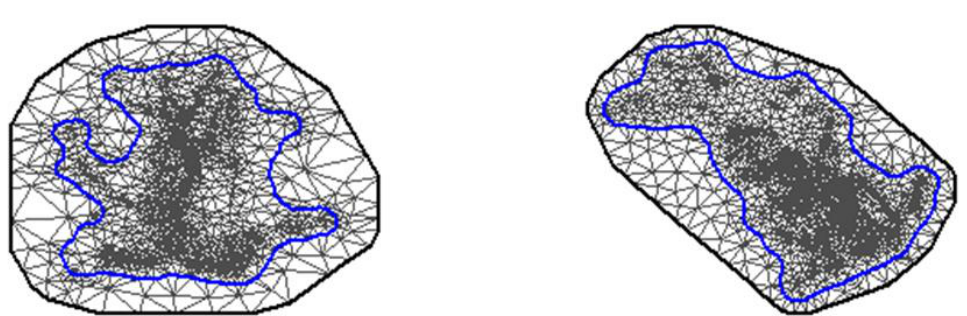
Figure A1. The meshes created by the Voronoi triangulation for the stochastic partial differentiation equation (SPDE) model for the GPS location density at the non-breeding (left panel) and breeding (right panel) grounds of American white pelicans. The mesh for the SPDE consisted of triangles and two outer polygons. The inner non-convex polygon (the blue line) encompassed all GPS locations at the non-breeding or breeding grounds defining the domain of the spatial effects. The area between the inner and outer polygons was used to account for the edge effect. The meshes were created for demonstrative purpose with the maximum edge length of 100 km and 200 km. The SPDE analysis used the maximum edge length of 40 km and 60 km.